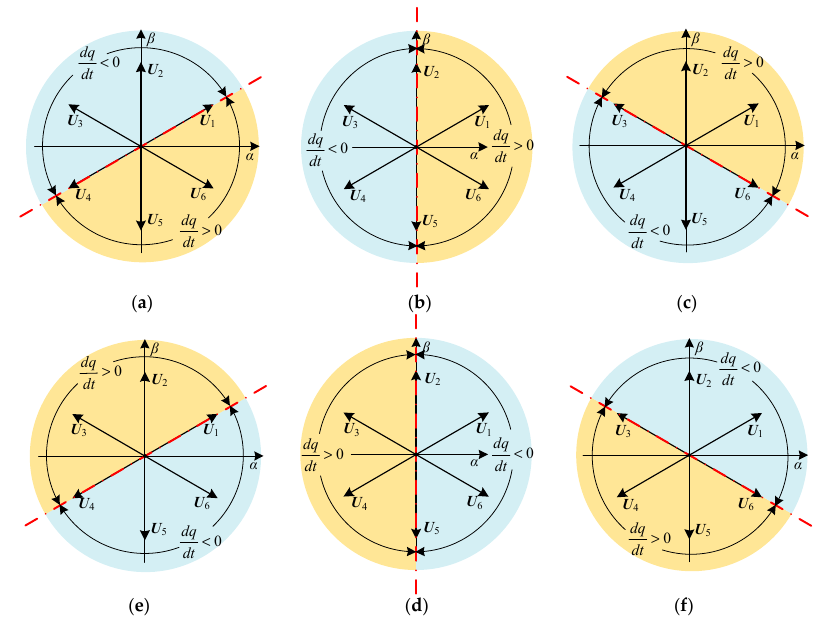
Figure 3. Illustration of areas divided by the synthesized voltage vectors’ effect on reactive power.